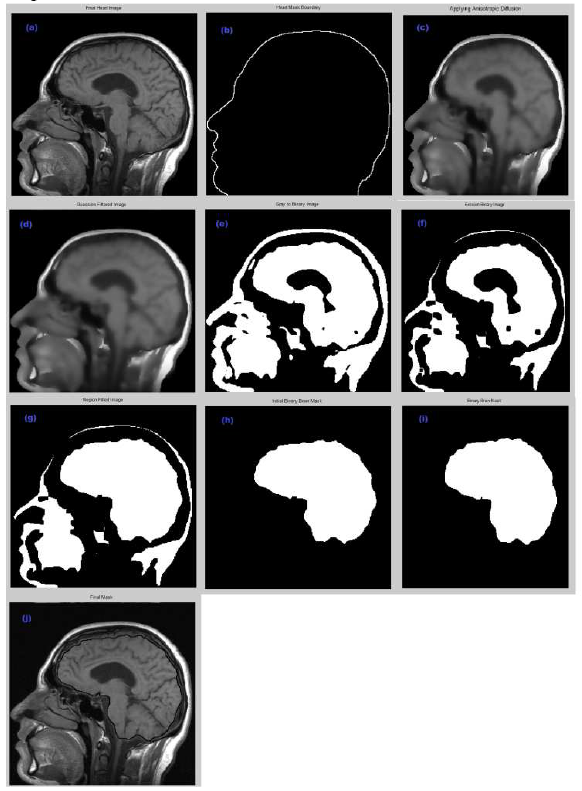
Fig.3 (a) Noised Removed Image, (b) Head Mask Boundary, (c) Applied Anisotropic Diffusion, (d) Applied Gaussian Filter, (e) Binary Conversion, (f) Applied Erosion, (g) Region Filled, (h) Eliminating non brain parts, (i) Applied dilation, (j) Initial Brain